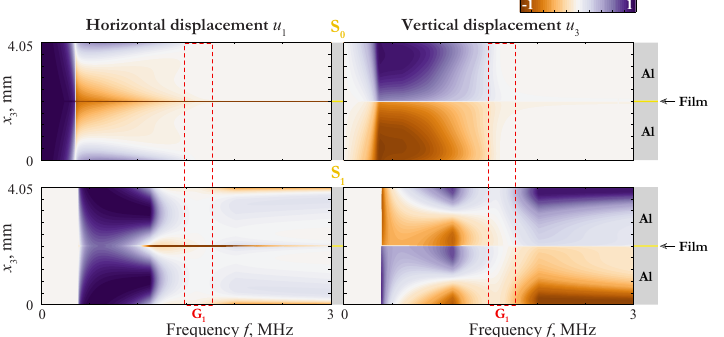
Figure 10. Displacement distribution u k ( x 3 , f ) of SLWs propagating in 4.05 mm thickness plate (2 mm